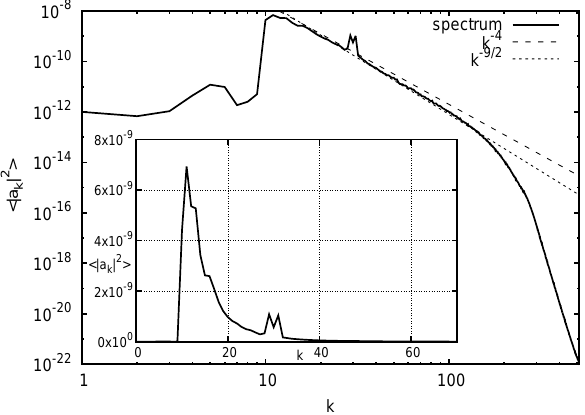
Figure 8. Angle-averaged spectrum with the condensate sup- pressed. Slopes for the KZ spectrum and Phillips spectrum are shown for a reference by dashed and dotted lines respectively. Main figure: logarithmic scale; inset: linear